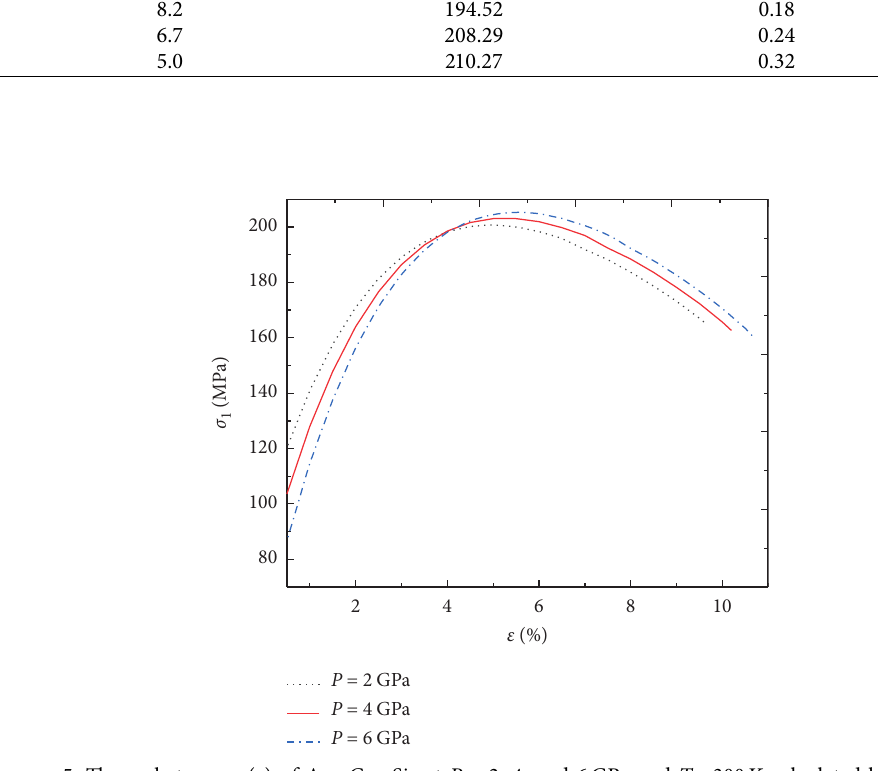
Table 5: Values of ε � f F ( f ( ε F ) max ), σ 1max , ε e , and σ e for Au 88 Cu 10 Si 2 at T (K)